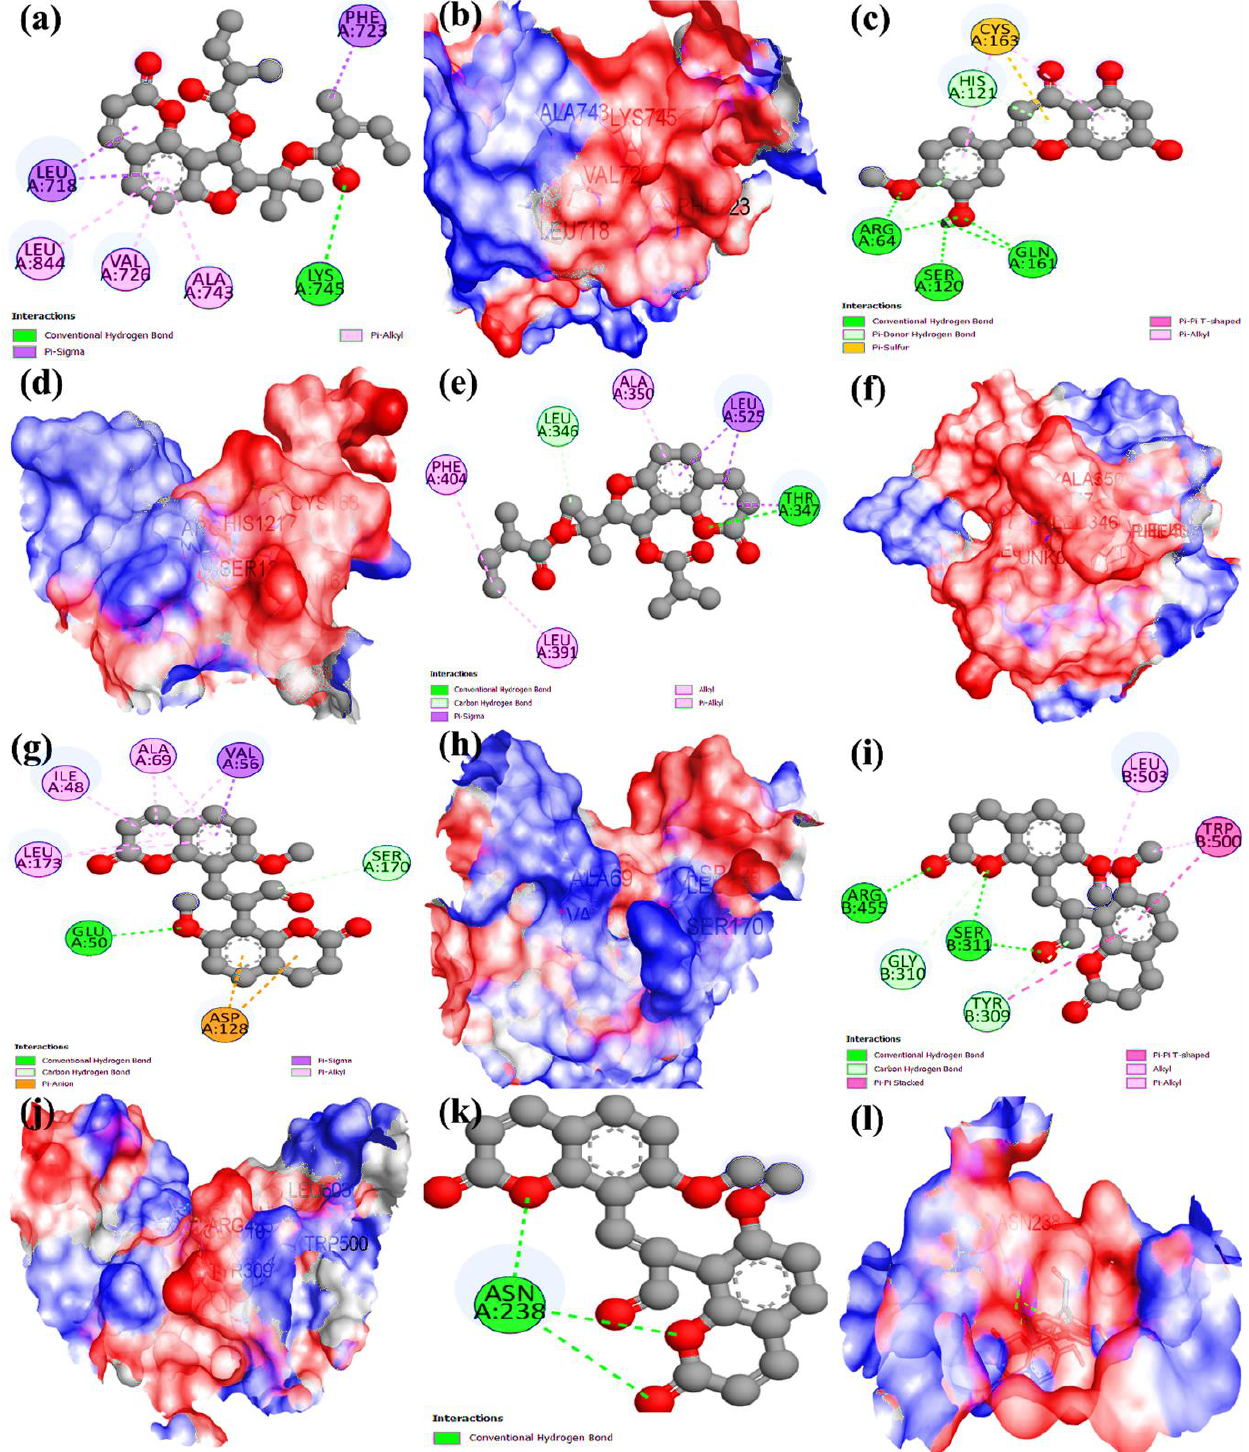
Figure 9. Molecular docking results of key active phytochemicals with anti-HCC core targets. ( a , b ) (2D and 3D) MOL003591 binds with EGFR. ( c , d ) (2D and 3D) MOL002881 binds with CASP3. ( e , f ) (2D and 3D) MOL003607 binds with ESR1. MOL003605 binds with ( g , h ) (2D and 3D) MAPK3, ( i , j ) (2D and 3D) CCND1, and ( k , l ) (2D and 3D) ERBB2.